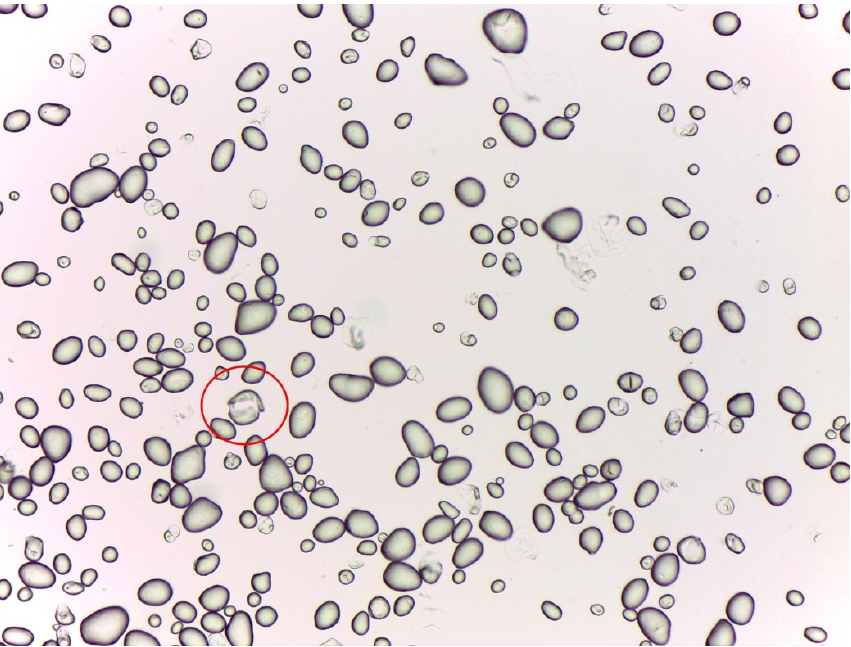
Figure 2. Damaged potato starch granule (marked with a red circle).